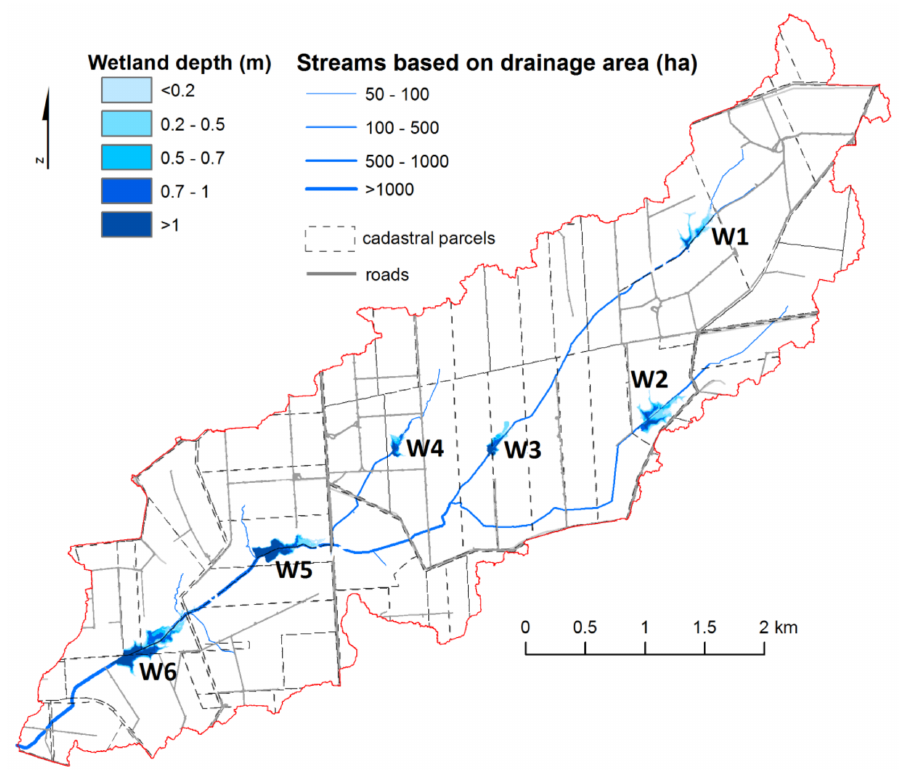
Figure 7. Six potential wetland sites delineated based on the wetland suitability map, along with cadastral